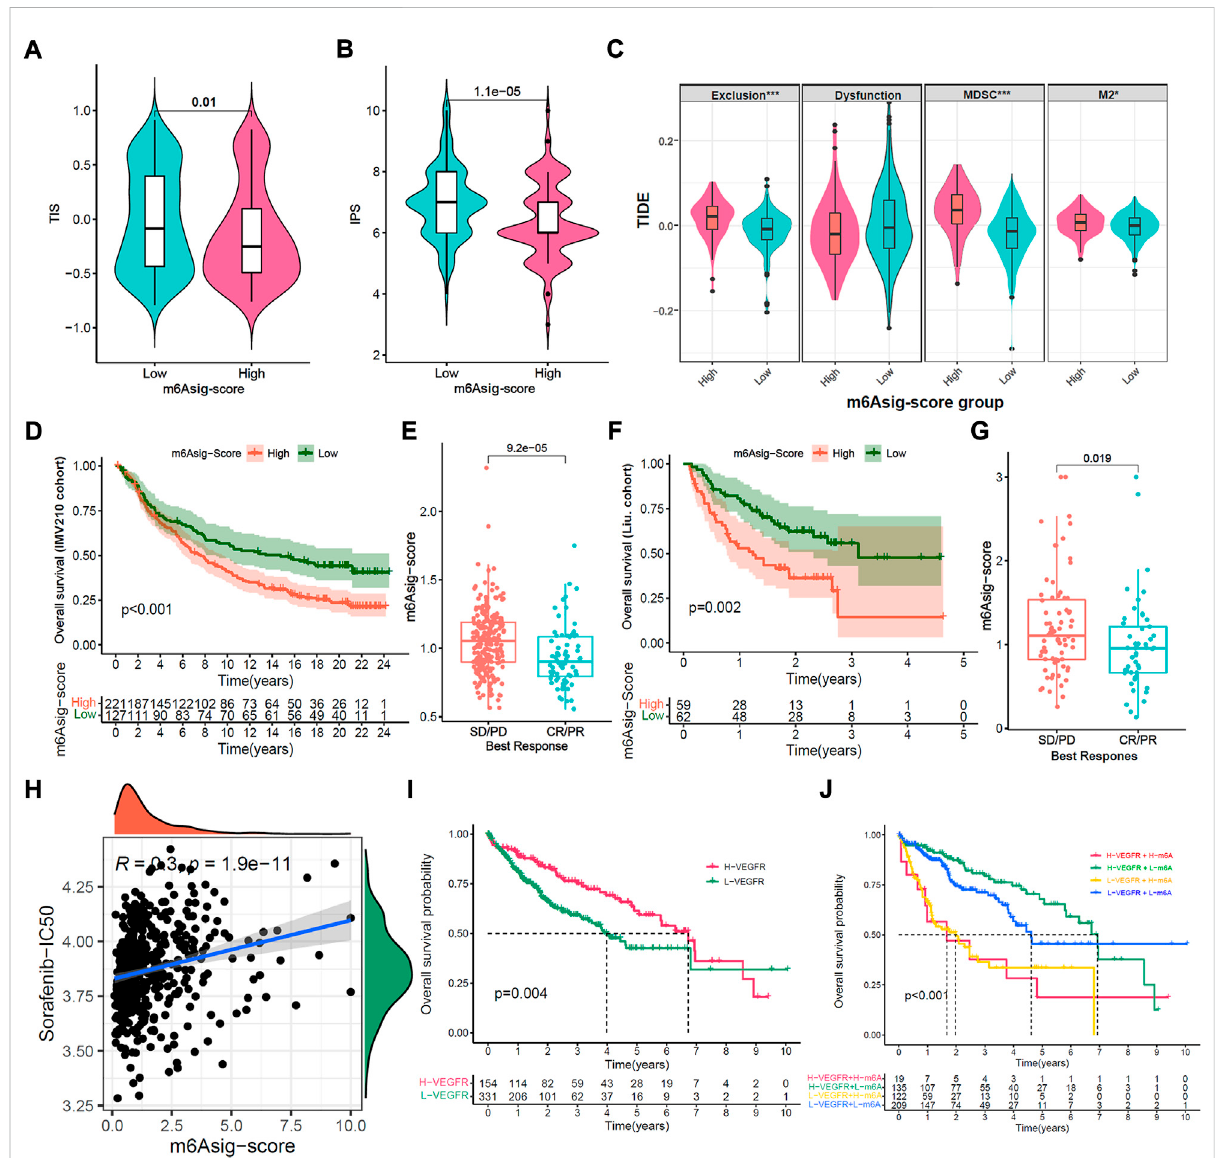
FIGURE 7 Prediction of m6Asig-Score in immunotherapy and anti-angiogenic therapy. (A – C) The relative distribution comparison of TIS (A) , IPS (B) and TIDE (C) betweenhigh m6Asig-Scoreand low m6Asig-Score groups. (D) Kaplan-Meier analysis between high m6Asig-Scoreand low m6Asig-Score groups in IMvigor210 cohort ( p < 0.001, Log-rank test). (E) The comparison of m6Asig-Score between SD/PD and CR/PR two groups in IMvigor210 cohort. (F) Kaplan-Meier analysis between high m6Asig-Score and low m6Asig-Score groups in Liu. cohort ( p = 0.002, Log-rank test) (G) The comparison of m6Asig-Score between SD/PD and CR/PR two groups in Liu. cohort. (H) Spearman correlations analysis between sorafenib-IC 50 and m6Asig-Score. (I) Overall survival Kaplan-Meier curves for high VEGFR-score and low VEGFR-score groups in the merged HCC cohort ( p = 0.003, Log-rank test). (J) Kaplan-Meier survival analyses for patients strati fi ed by m6Asig-Score and VEGFR-score. H, high; L, Low; Ve., VEGFR; m6A., m6Asig-Score ( p < 0.0001, Log-rank